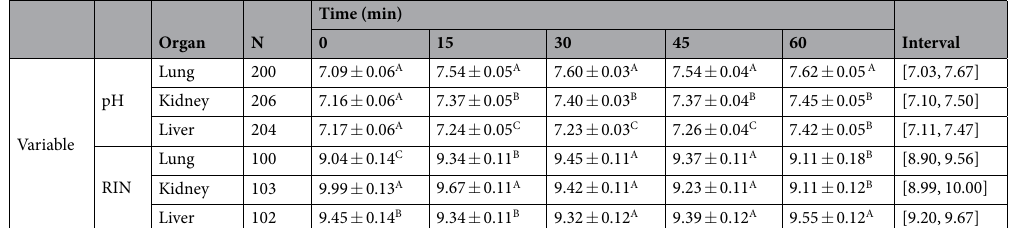
Table 1. Ischemia time dependent variables. Model results are expressed as mean ± standard error for each variable of interest. Different superscript letters indicate Fisher’s least significant difference (p < 0.05) using